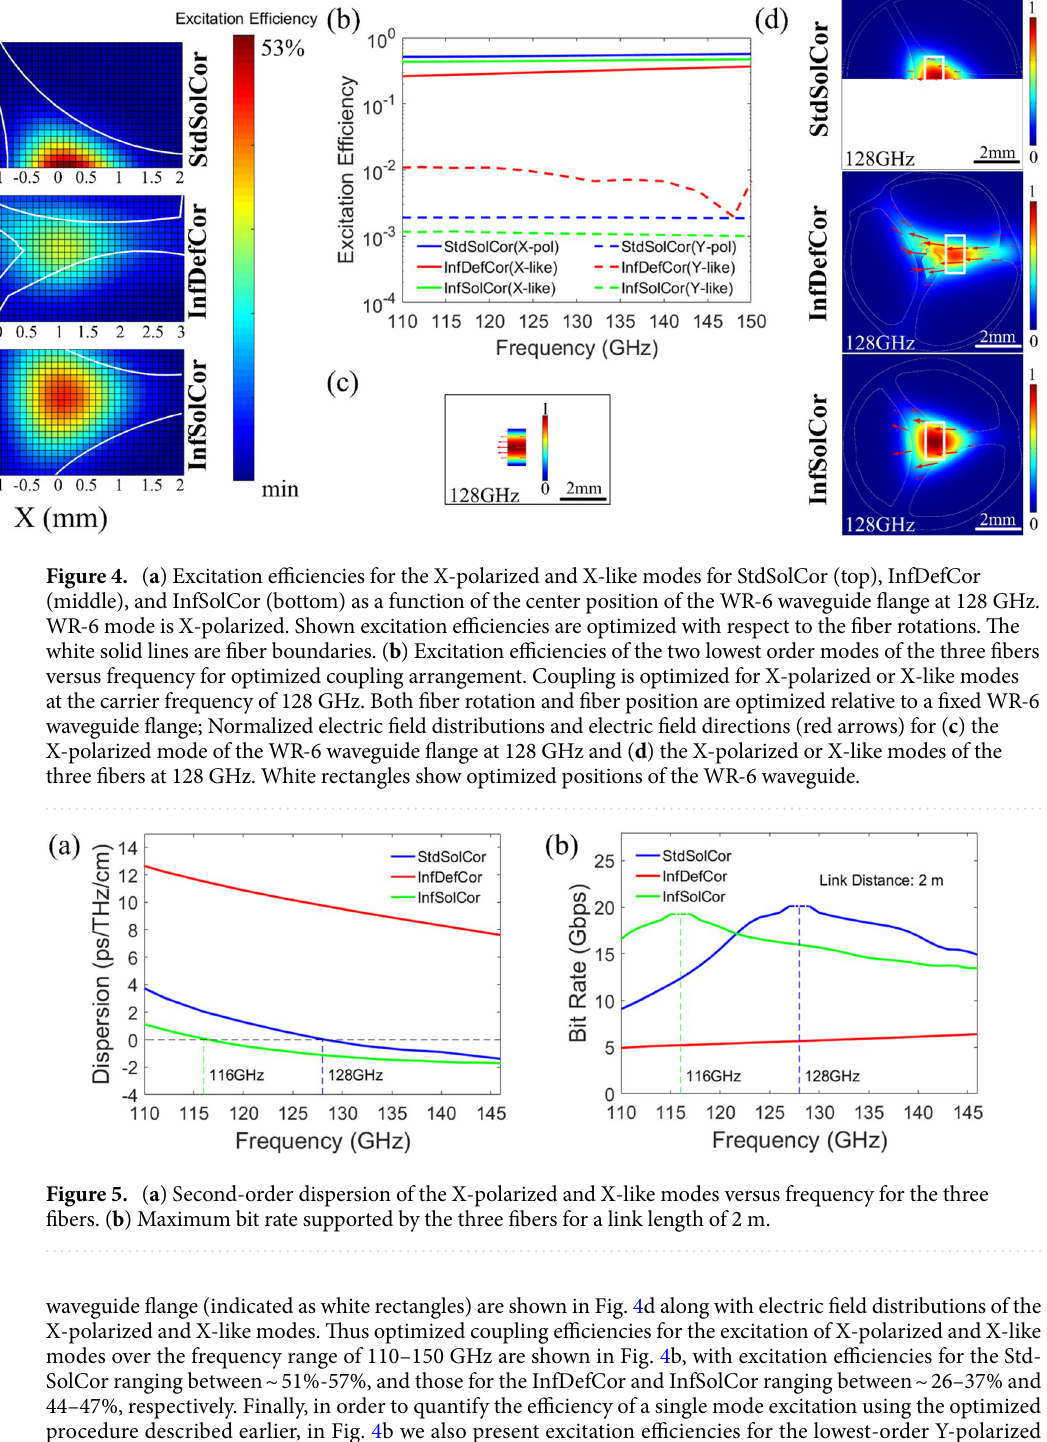
waveguide flange (indicated as white rectangles) are shown in Fig. 4d along with electric field distributions of the X-polarized and X-like modes. Thus optimized coupling efficiencies for the excitation of X-polarized and X-like modes over the frequency range of 110–150 GHz are shown in Fig. 4b, with excitation efficiencies for the Std- SolCor ranging between ~ 51%-57%, and those for the InfDefCor and InfSolCor ranging between ~ 26–37% and 44–47%, respectively. Finally, in order to quantify the efficiency of a single mode excitation using the optimized procedure described earlier, in Fig. 4b we also present excitation efficiencies for the lowest-order Y-polarized and Y-like modes calculated for the optimal excitation conditions of the X-polarized and X-like modes, and note that they are all below 1%. This confirms that the optimized excitation procedure developed in our work guarantees an effectively single mode excitation with 14–27 dB suppression (by power) of other lowest order modes in all three fibers. Study 3: modal group velocity dispersion and maximum bit rate. Another important factor affecting signal qual- ity transmitted through optical fibers is dispersion. While the intensity of a received signal should be signifi- cantly above the receiver detection level, it is also essential to minimize signal distortion due to dispersion. The dispersions of X-polarized or X-like modes for the three fibers as a function of frequency are shown in Fig. 5a. The dispersion of StdSolCor at the carrier frequency of 128 GHz is near zero by design while it is in the range of